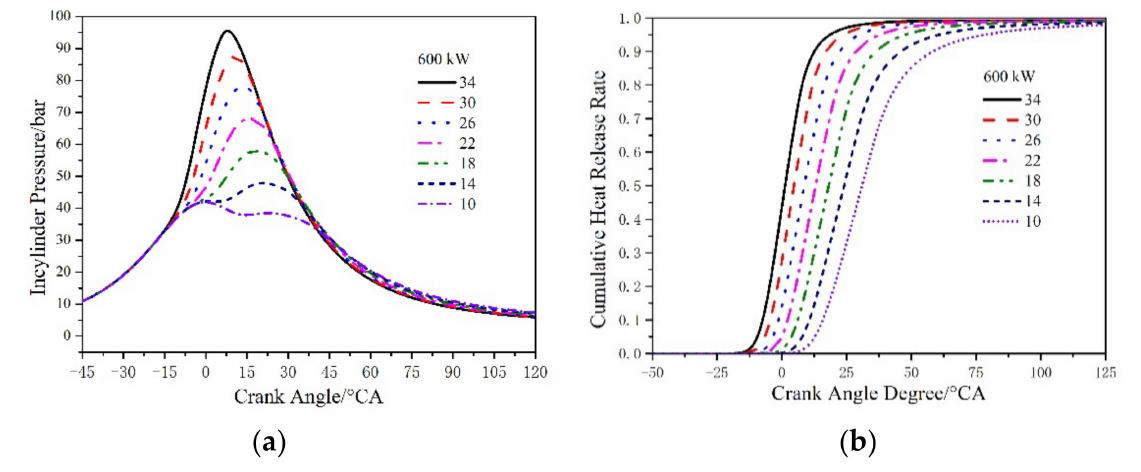
Figure 6. ( a ) Effect of Ignition Delay on Engine Cylinder Pressure. ( b ) Effect of Ignition Delay on Engine Heat Release